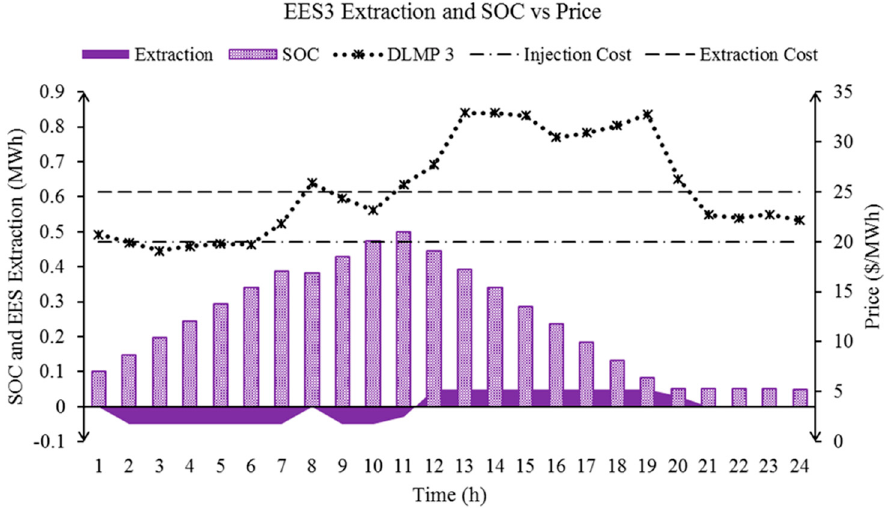
Figure 11. EES3’s schedule is dependent upon the DLMP at Bus 3.